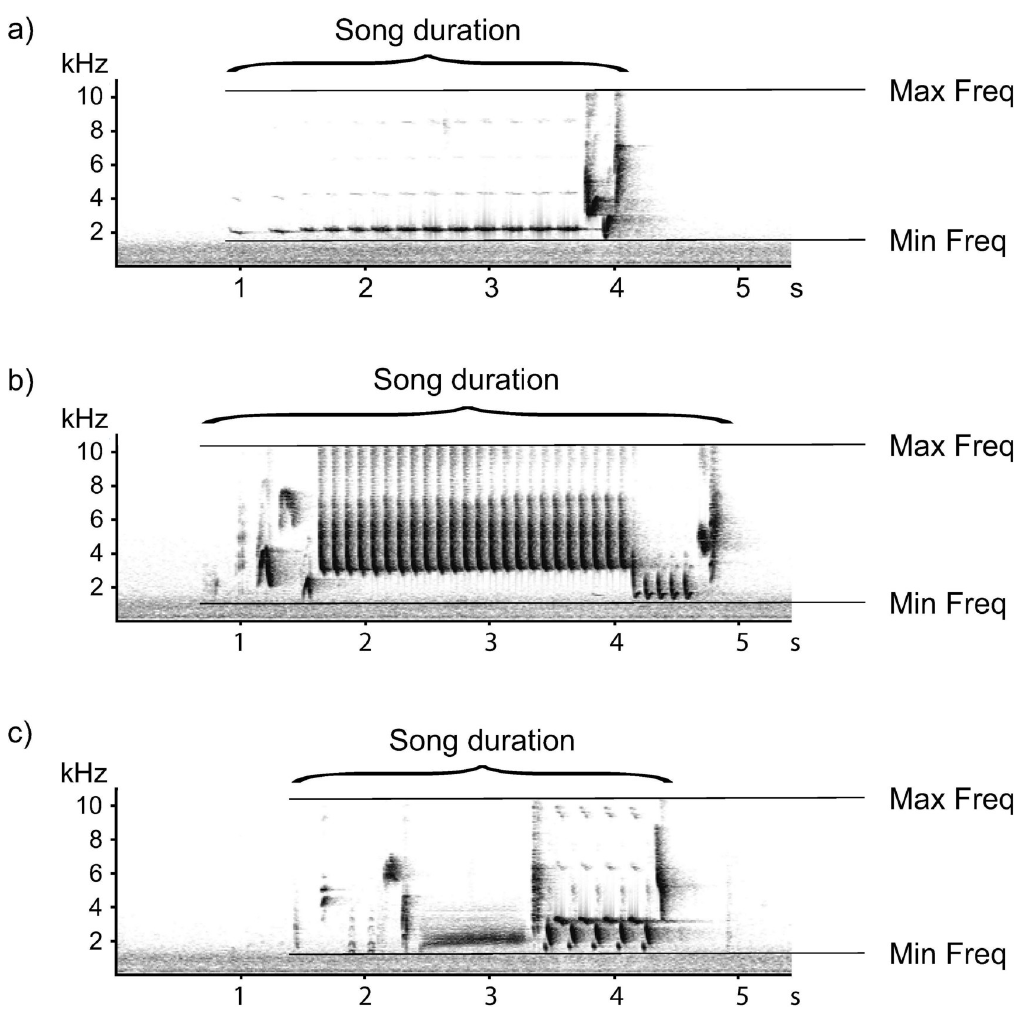
Fig 1. Exemplary spectrograms demonstrating the measured temporal and spectral parameters of the song duration, maximum frequency (Max Freq) and minimum frequency (Min Freq) in nightingale song for a) whistle songs, b) trill songs and c) buzz